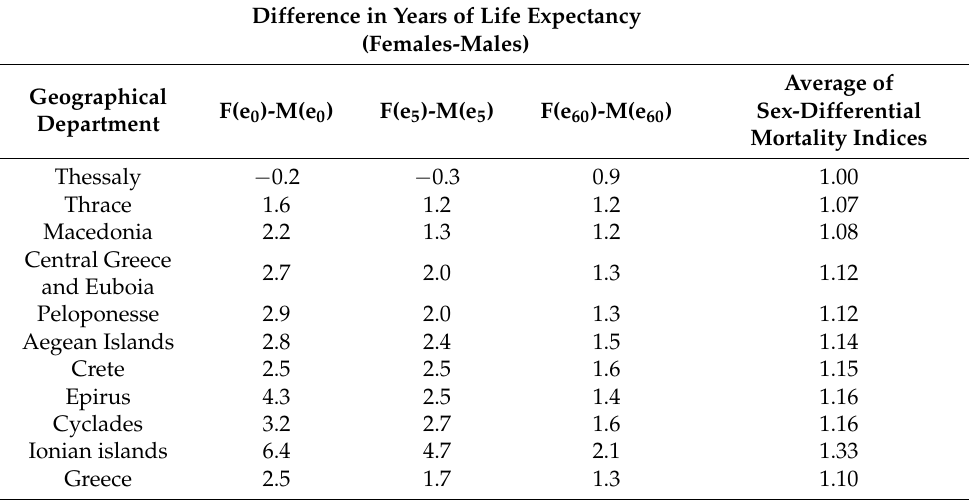
Table 1. Geographical Departments by sex-differential mortality. Greece